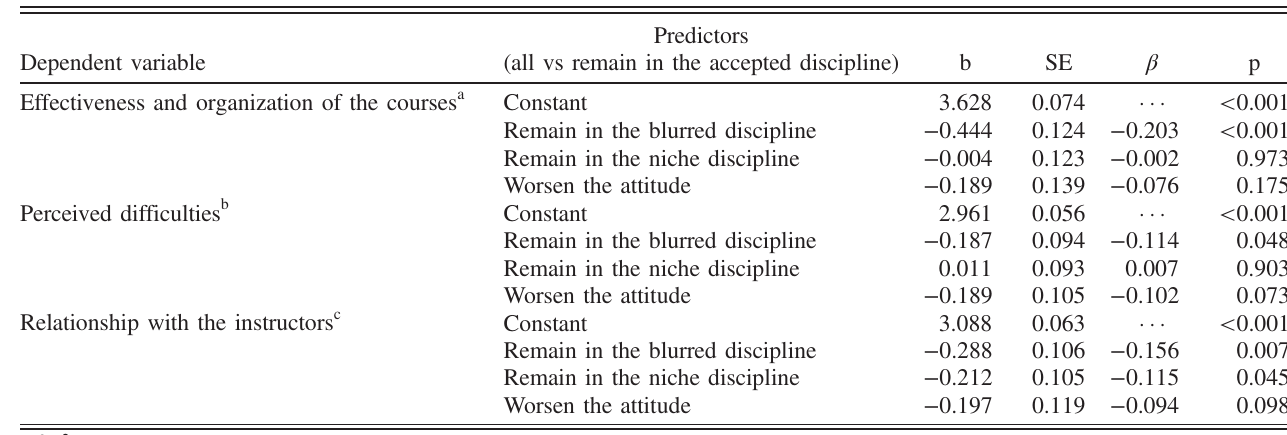
TABLE III. Linear model of predictors of three latent dimensions of the perception of emergency remote instruction